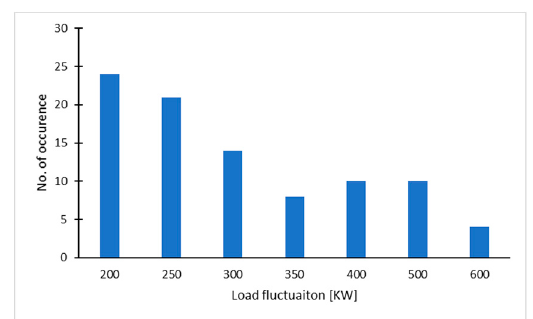
Figure 12. Special event load fluctuation distribution.